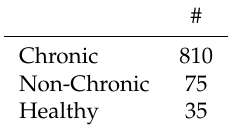
Table 1. Number of samples for each